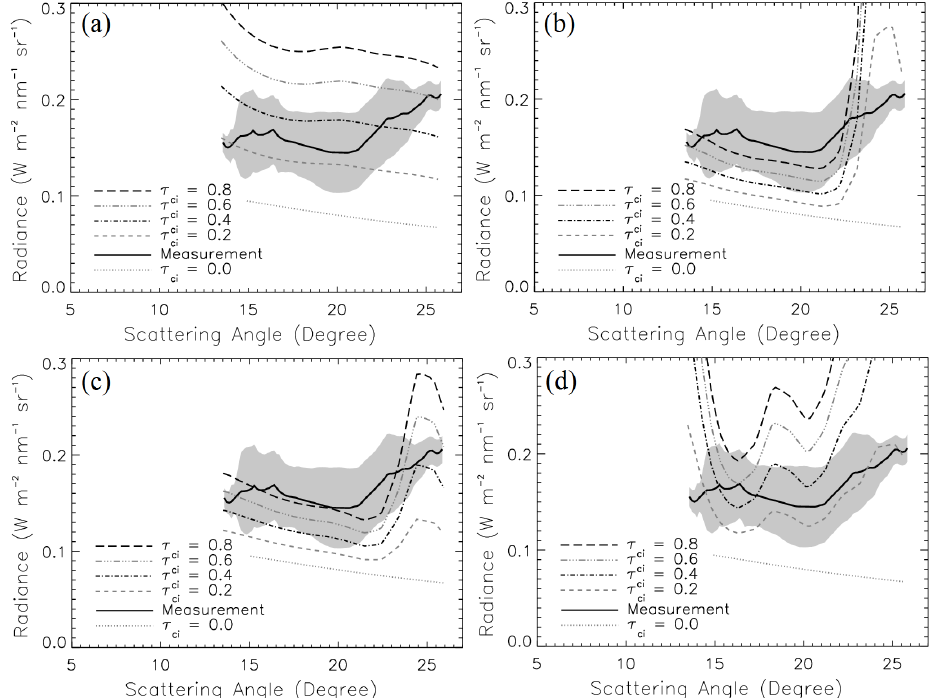
Fig. 12. Measured and simulated I ↓ as a function of scattering angles. The standard deviation of the measurement is represented by the grey shade. Measurement from 23 April 2011. The simulations were performed for different τ ci and an assumed ice crystal shape of (a) rough aggregates, (b) solid columns, (c) plates, and (d) mixture.